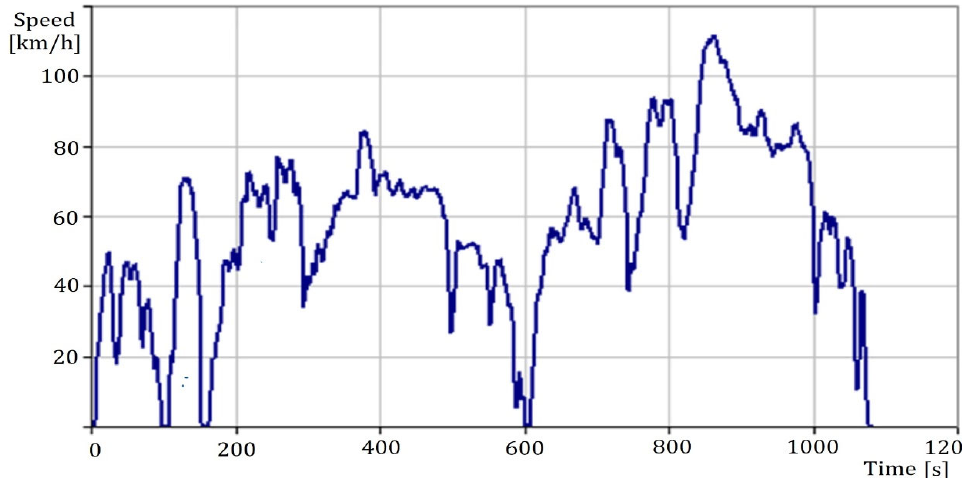
Figure 10. Simulated electric car test drive.